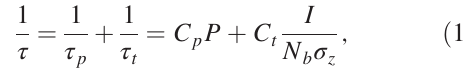
FIG. 15. Dependence of 1 = τ on (a) I= ð N b σ z (b) I= ð N b σ z Þ at P ¼ 6 – 8 × 10 − 8 Pa for the LER.